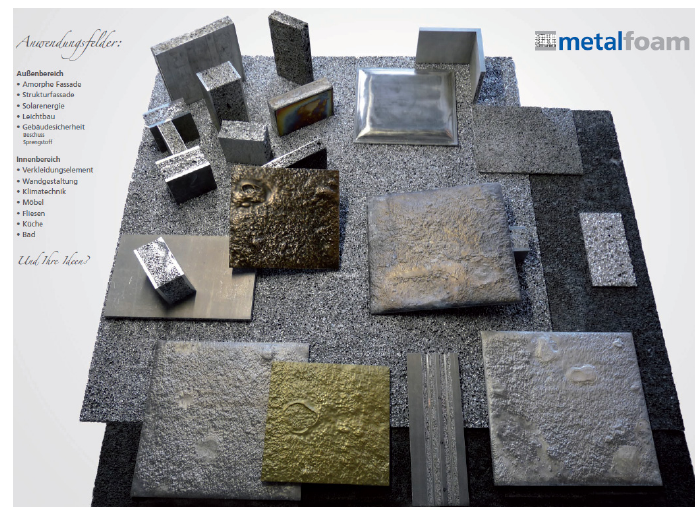
Figure 20. Different AFS, cut AFS and tiles made of AFS for internal architectural applications (Courtesy of Pohltec Metalfoam).